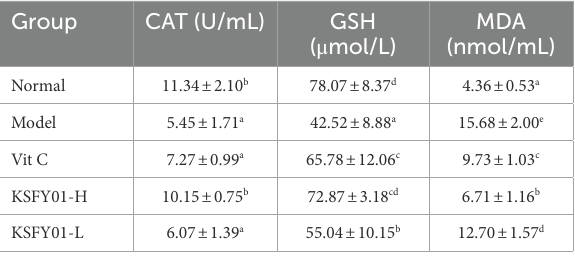
TABLE 4 The CAT, GSH, and MDA levels in aging